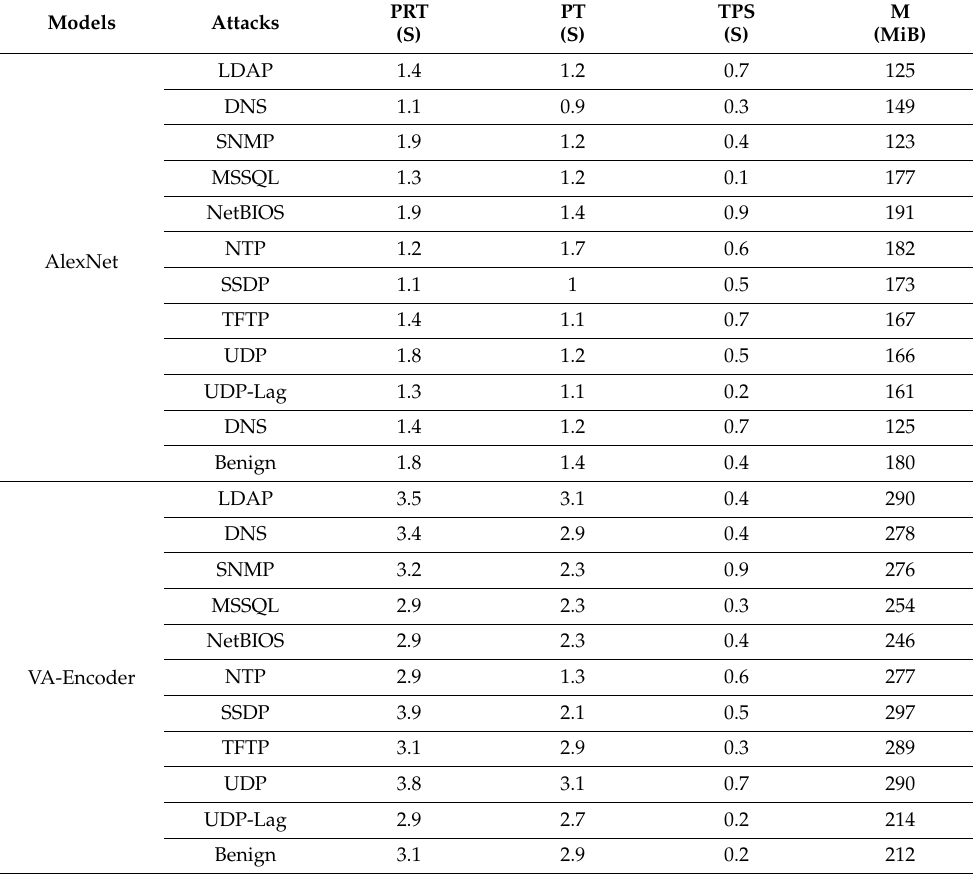
Table 5. Performance of the ML Models in terms of PRT, PT, TPS, and M for TEST data.